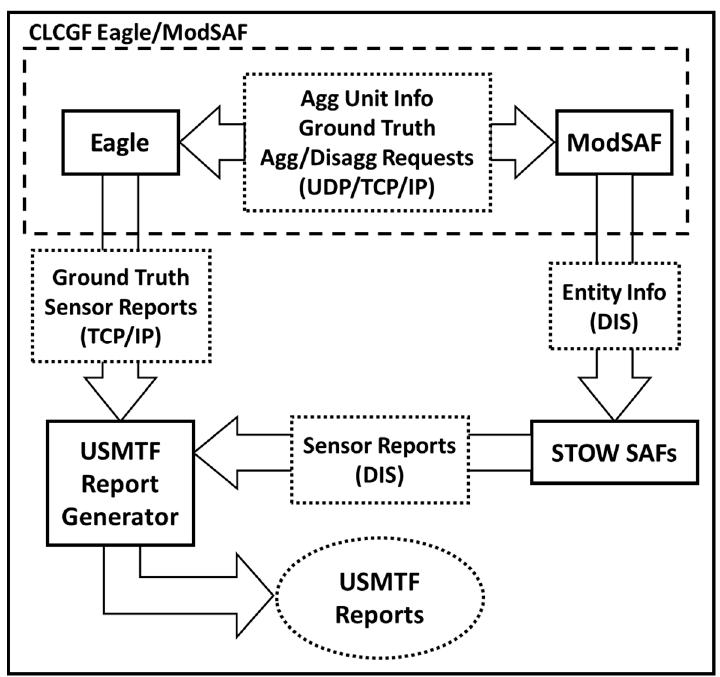
Figure 12. DMIF test/evaluation conceptual architecture (adapted from [42]).